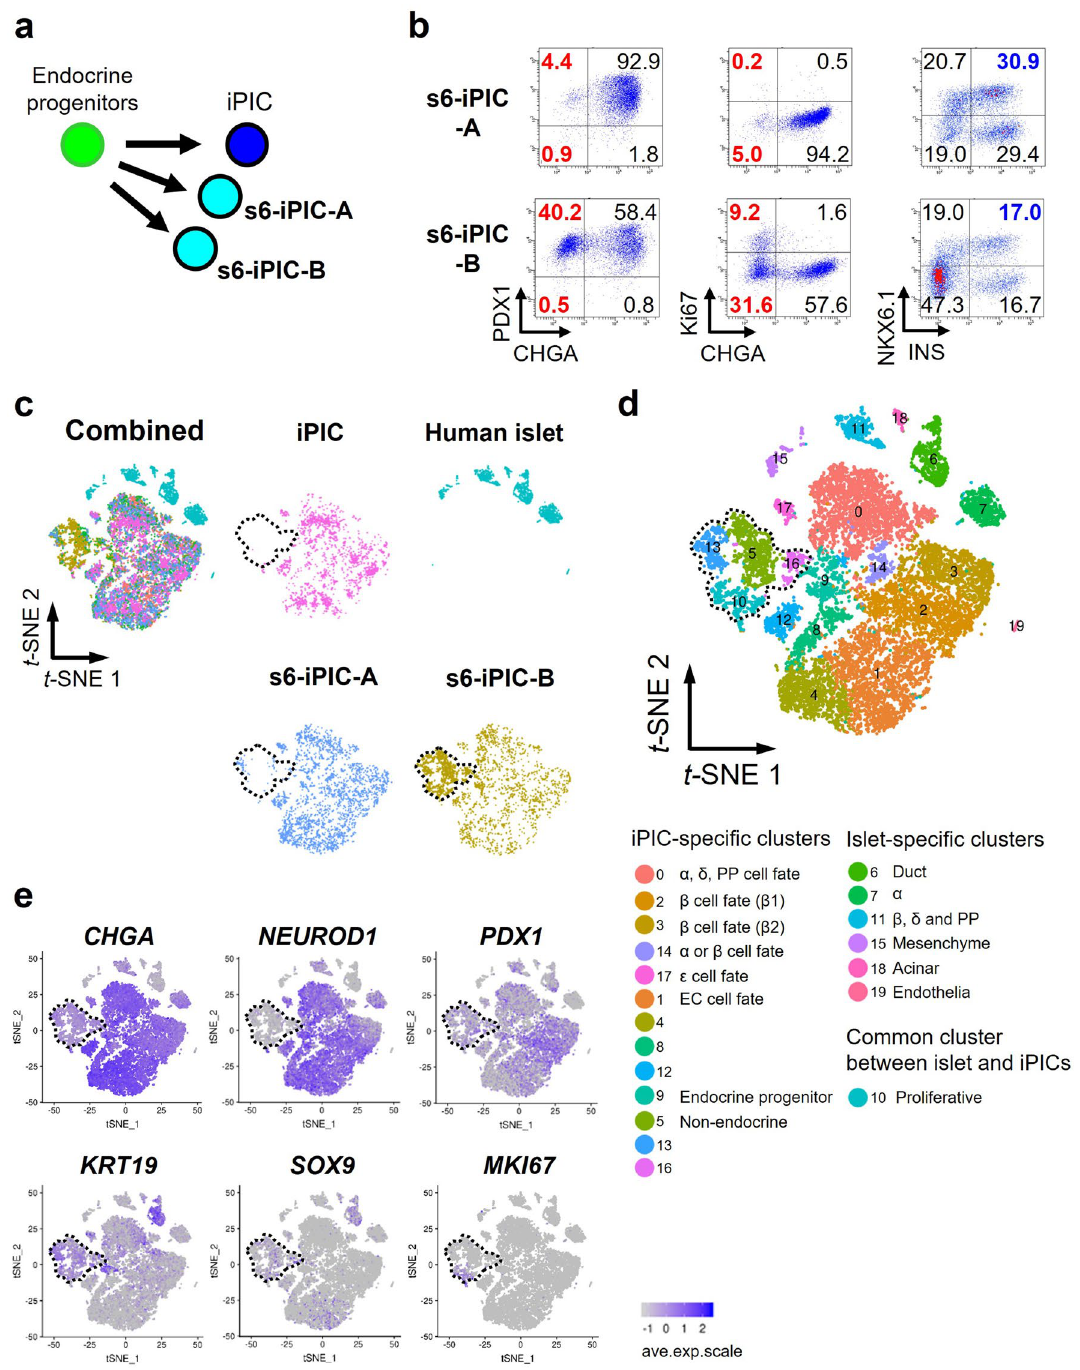
Figure 2. Classification of the cells composing iPIC and extraction of non-endocrine cells through single-cell RNA sequencing. ( a ) Schematic representation of three versions of iPICs differentiation subjected to single-cell RNA sequencing. ( b ) Representative flow-cytometry plots illustrating the protein expression of s6-iPIC-A (upper) and s6-iPIC-B (lower). The presented plots are those of samples for single-cell RNA sequencing. ( c ) A combined cell distribution from a total of six samples and individual cell distributions. The six samples are as follows: 1 sample of iPIC, 3 samples of s6-iPIC-A, 1 sample of s6-iPIC-B, and 1 sample of reference human islet. For s6-iPIC-A, only a representative sample of the 3 samples is shown. For the remaining two samples of s6-iPIC-A, individual t- SNE projects are shown in Supplementary Fig. 3a. The dotted line in black represents the non-endocrine ( CHGA - NEUROD1 - ) population from the iPICs, as shown in ( e ). ( d ) Shared nearest neighbors clustering identified fourteen cell clusters for in vitro differentiated iPICs (0–5, 8–10, 12–14, 16, and 17) and seven clusters for human islet samples (6, 7, 10, 11, 15, 18, and 19). Clusters 1, 4, 8, and 12 are all EC cell fate, while Clusters 5, 13, 16 are all non-endocrine cell. The dotted line in black represents the non-endocrine population (Clusters 5, 13, 16, and CHGA - population of Cluster 10) from the iPICs. ( e ) Single-cell gene expression of representative markers related to the pancreas, endocrine cells and proliferation in combined t -SNE projections. The dotted line in black represents the non-endocrine population from the